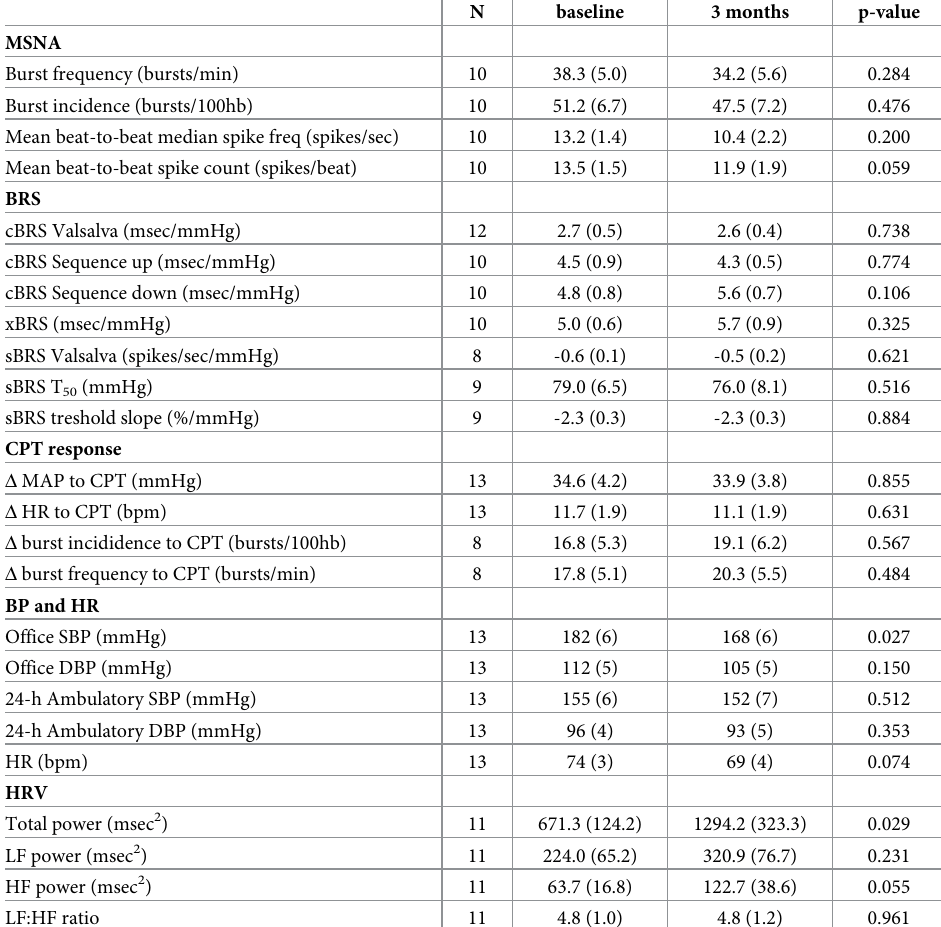
Table 2. Sympathetic and cardiovascular parameters at baseline and 3 months after implantation.